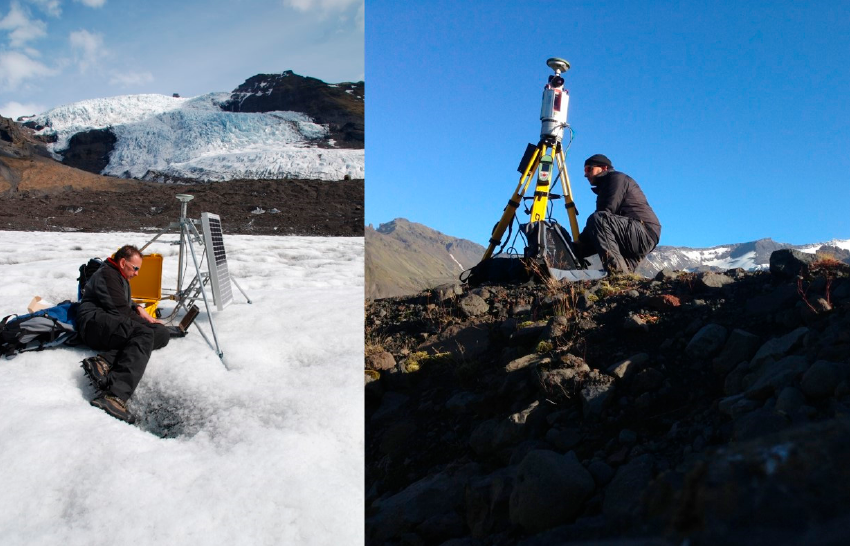
Figure 10. Data download of on-ice GNSS unit. Terrestrial LiDAR Scanning of glacial foreland, Falljökull Glacier, Iceland.